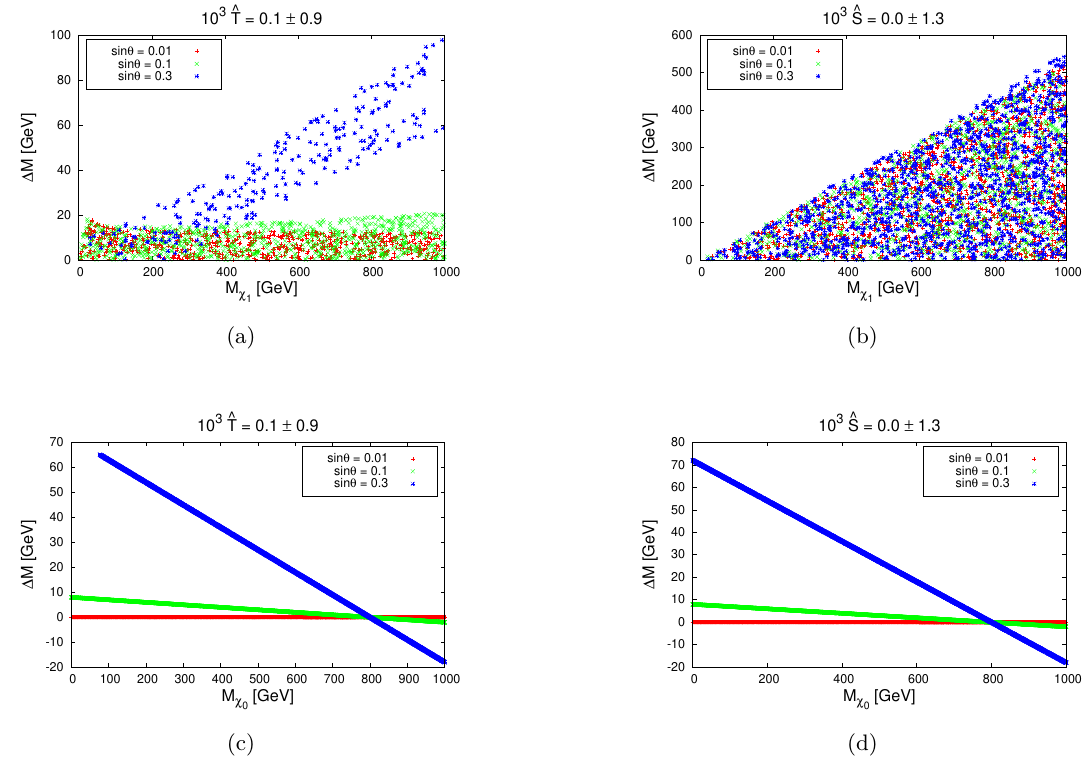
) coming from the EWPO (a) ˆ T and (b) ˆ S with Figure 1 . Constraints on ∆ M = ( M χ − M L 1 1 respective to M for three different values of sin θ = 0 . 01 , 0.1 and 0.3 when both M and M χ 1 χ 1 L 1 are varied randomly. Here M = 120 GeV is assumed. (c) and (d) shows the variation of ∆ M as a χ 0 function of M , when M = 800 GeV and M is given by eq. (3.14). χ 0 χ 1 L 1 It can be directly verified that the divergent parts along with the scaling factor µ get cancelled when eq. (3.12) or eq. (3.13) is substituted in eq. (3.11). ( M ) , we depict its variation with M in figure 1(a) and figure 1(b) for three different − M χ 1 χ 1 L 1 values of sin θ = 0 . 01 , 0.1 and 0.3 keeping DM mass M = 120 GeV. Clearly, electroweak χ 0 precision constraints on ˆ S is much relaxed compared to the oblique parameter ˆ T to the new fermions. For moderate or smaller values of χ mass, one finds that ∆ M ≤ O (20) GeV is 1 allowed by the oblique parameter ˆ T , which sets an upper bound on sin θ ( ’ 0 . 1